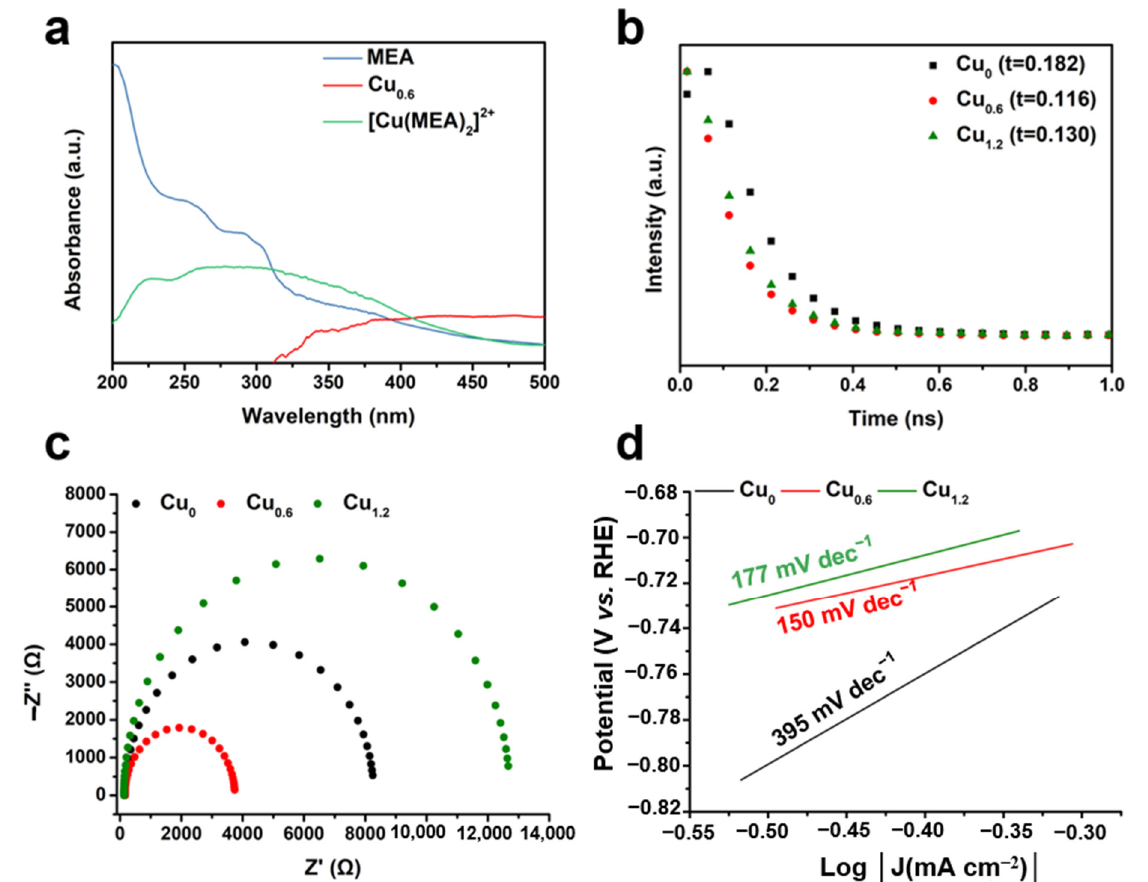
Figure 12. ( a ) UV-vis spectra of MEA (blue), Cu 0.6 (red), and [Cu(MEA) 2 ] 2+ (green). ( b ) Fluorescence decay spectra of Cu 0 (black), Cu 0.6 (red), and Cu 1.2 (green). ( c ) Electrochemical impedance spectroscopy (EIS) of Cu 0 (black), Cu 0.6 (red), and Cu 1.2 (green). ( d ) Tafel slopes of Cu 0 (black), Cu 0.6 (red), and Cu 1.2 (green).